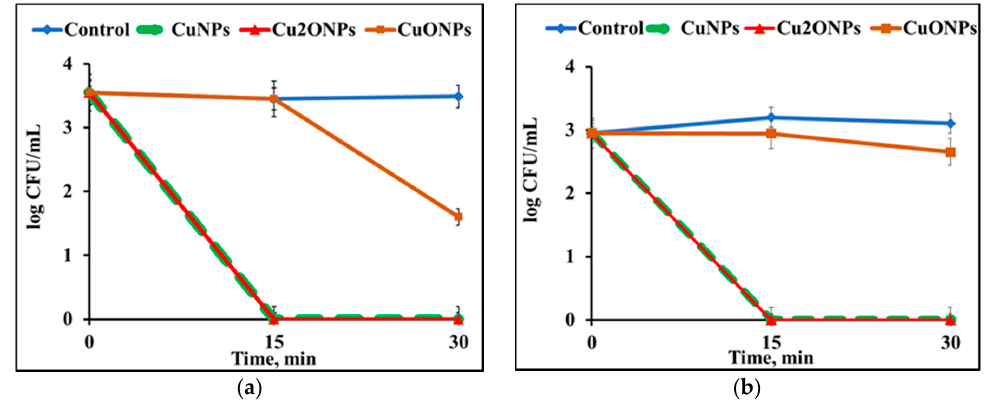
Figure 6. Activity of NPs of free copper and its oxides against ( a ) S. aureus and ( b ) E. coli cells at 25 °C. Control—untreated bacterial cells. Control—untreated bacterial cells.